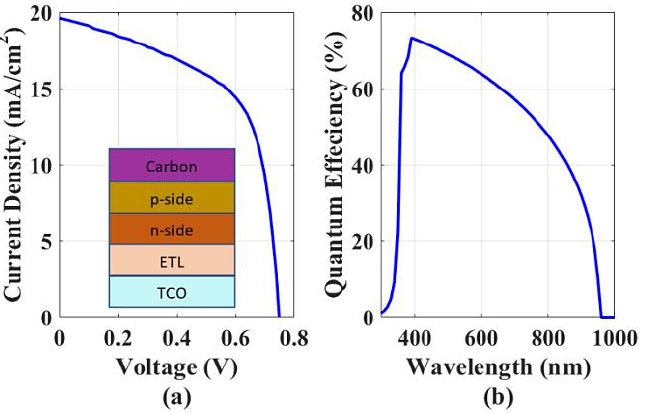
Figure 12. HTL-free structure characteristics: ( a ) the illuminated J – V , ( b ) the quantum